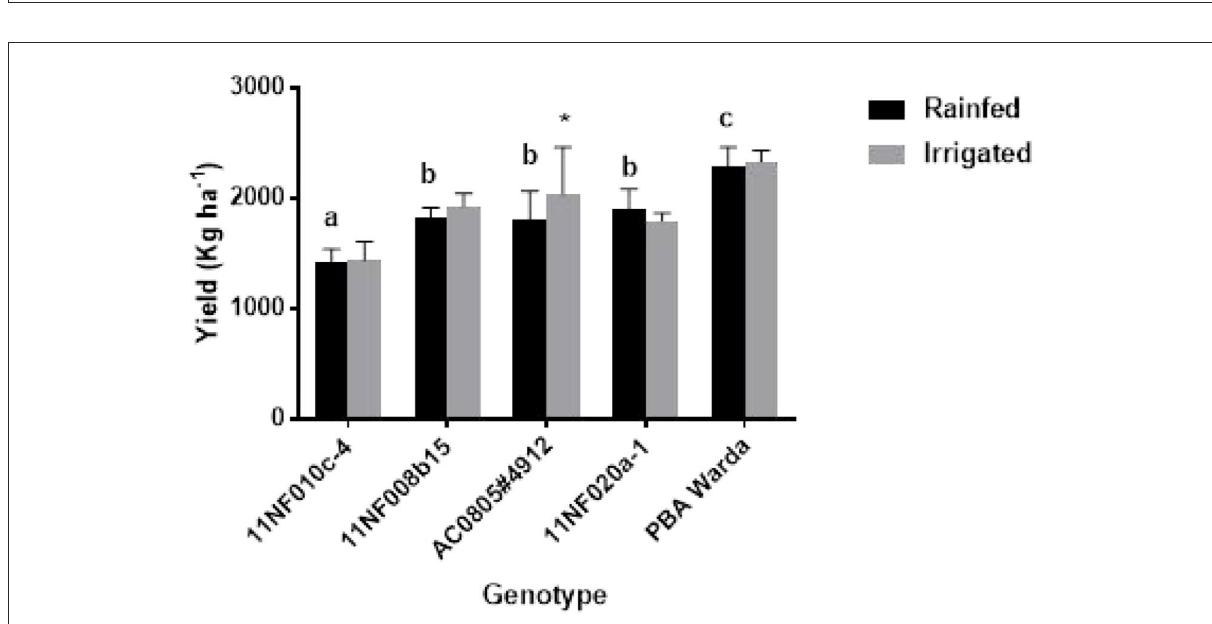
FIGURE6 Yield (kg ha − 1 ) of contrasting faba bean genotypes grown under field conditions (irrigated and rainfed trial) at Narrabri, Australia. Error bars were calculated from four replicates and represent standard error of the mean. Letters denote a significant difference ( p < 0.05) among genotypes calculated through DMRT. Asterisks (*) represent significance between irrigated and rainfed